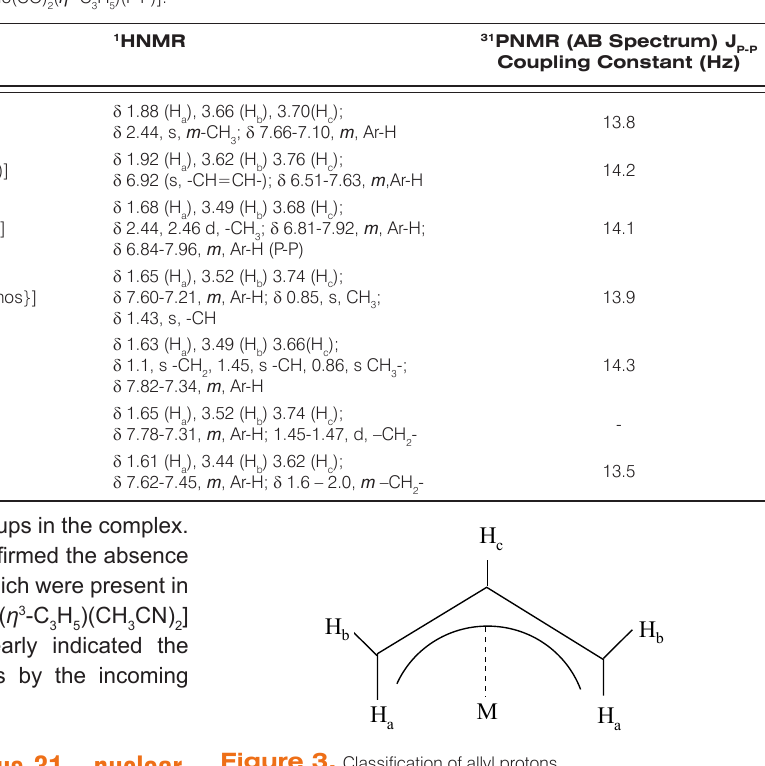
( η 3 -C H )(P-P)]. 2 3 5